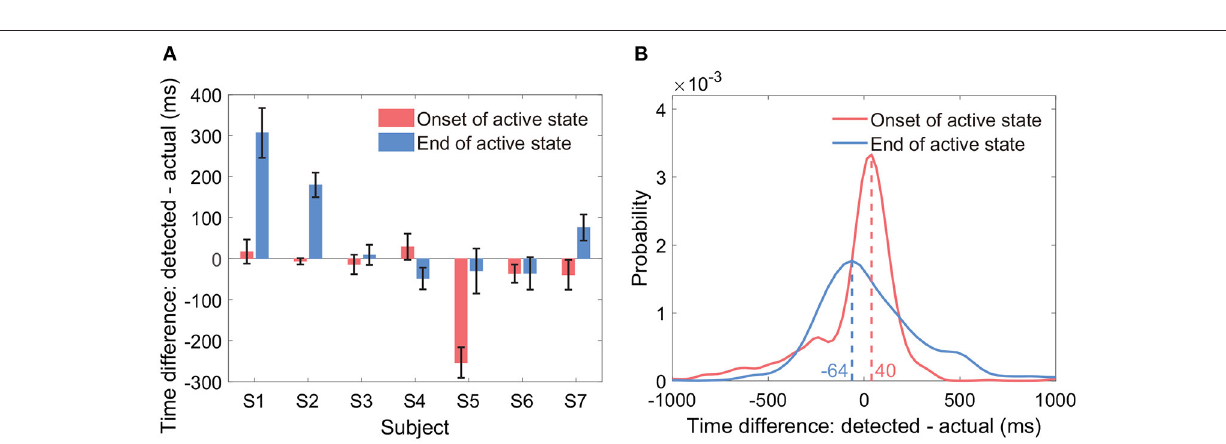
FIGURE 8 | Timing of the onset and the end of detected active states. The sub-figures display the time difference between the detected active state onset and the actual active state onset, and the time difference between the detected active state end and the actual active state end. (A) Displays the two types of time differences within each subject (mean ± ste). (B) Displays the empirical distributions of the two types of time differences by group analysis of all active state periods from all